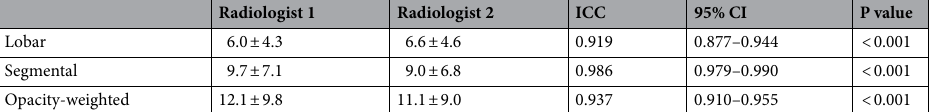
Table 3. The ICC results of lobar/segmental lesion assessments between Radiologist 1 and Radiologist 2. ICC intraclass correlation coefficient, CI confident interval, CI confidence